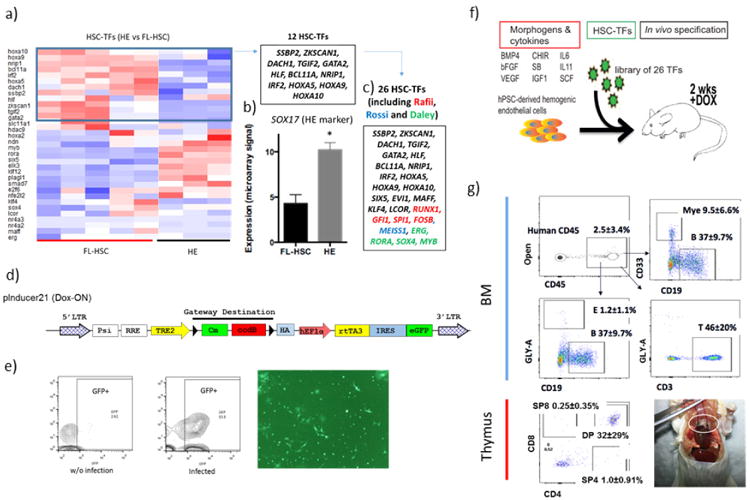
Rationale for selecting candidate transcription factors for library screeninga, Heatmap of the expression profile of HSC-specific transcription factors (TFs) in haemogenic endothelium (CD34+FLK1+CD43−CD235A−) versus fetal-liver HSCs (CD34+CD38−CD90+CD45+). Twelve HSC-specific transcription factors enriched in fetal-liver HSCs relative to haemogenic endothelium (blue box) were cloned individually into a Dox-inducible lentiviral vector. b, The expression level of SOX17, a marker of haemogenic endothelium, was 2.4-fold higher in haemogenic endothelium (N = 7) than fetal-liver HSCs (N = 10). *P < 0.001. c, The library was supplemented with genes identified in previous screens. Candidates in red were drawn from a previous screen by the Rafii group3; blue from the Rossi group2; green from the Daley group7. The final library of 26 candidates is shown. d, Diagram of the Dox-ON pInducer-21 lentiviral vector used in this study (top). rtTA3 and eGFP are driven by EF1α -promoter; infection efficiency is indicated by the GFP signal. e, GFP analysis by FACS and fluorescence 3 days after infection of haemogenic endothelium cells. Routinely, over 50% transduction efficiency was achieved. For transplantation, haemogenic endothelium cells infected at day 3 EHT were incubated for 24 h and injected into mice. Dox was provided for 2 weeks in vivo after transplantation into sub-lethally irradiated immune-deficient NSG mice. f, Scheme for screening the 26 transcription factors library, and resulting haematopoietic chimaerism. hPSC-derived haemogenic endothelium was cultured for an additional 3 days in EHT medium, then infected with the library of 26 transcription factors. Infected cells (100,000) were injected intrafemorally into sub-lethally irradiated (250 rad) NSG mice, which were treated with doxycycline for 2 weeks to induce transgene expression in vivo. g, FACS analysis of bone marrow and thymus of an engrafted recipient is shown. Human CD45+ cells from bone marrow were analysed for CD33+ myeloid cells, CD19+ B cells, and CD3+ T cells as indicated. Thymic cells were analysed for human CD4 and CD8, with percentages of single and double-positive cells indicated. A photograph of an engrafted thymus is shown (bottom right). Data shown as mean ± s.d.